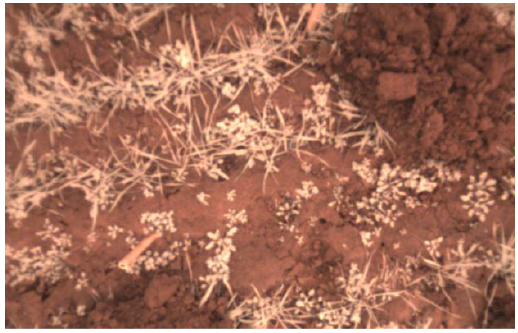
Figure 7. False color image of the modified camera. Weed in winter wheat is shown. The drilling distance was 14 cm and the shutter time was 250